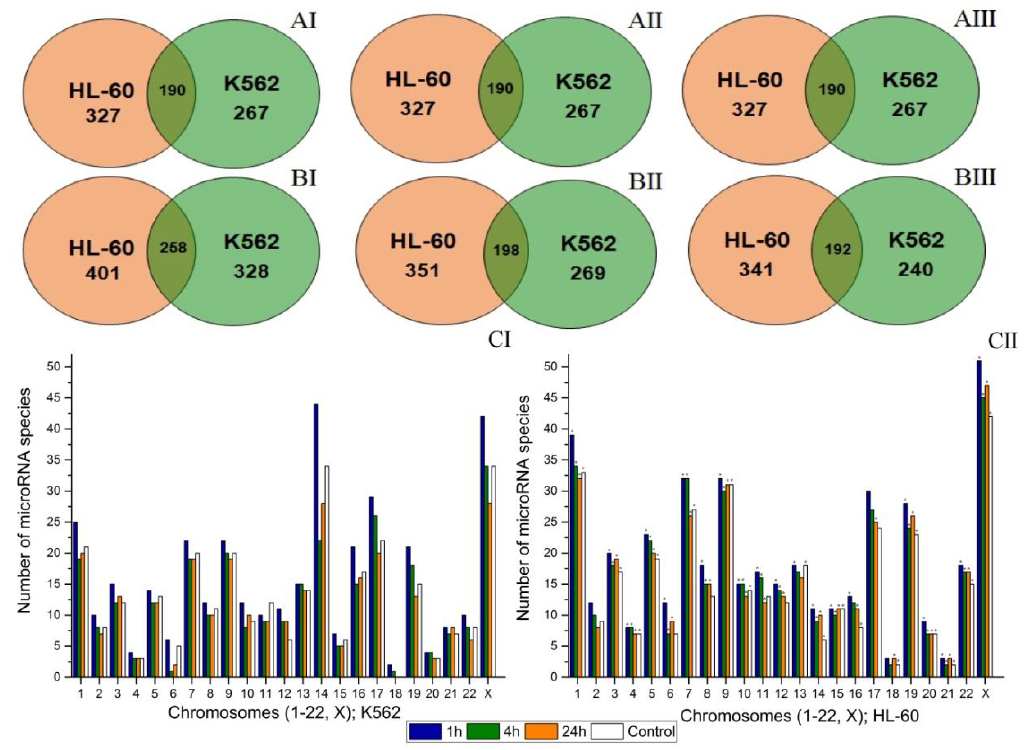
Figure 2. Effects of radiation exposure at the dose of 4 Gy on microRNA expression in the K562 and HL-60 cell lines. ( A , B ). The number of differentially expressed microRNAs in the HL-60 and K562 cell lines. AI , AII , AIII . The number of microRNAs in K562 and HL-60 cells in the control group 1, 4, and 24 h after irradiation, respectively. BI , BII , BIII . The number of microRNAs in K562 and HL-60 cells in the experimental group 1, 4, and 24 h after irradiation, respectively. CI . The number of expressed microRNAs depending on the chromosomal localization in the K562 cell line 1, 4, and 24 h after irradiation. CII . The number of expressed microRNAs depending on the chromosomal localization in the HL-60 cell line 1, 4, and 24 h after irradiation. *—Statistically significant difference from the K562 cell line, p < 0.05.